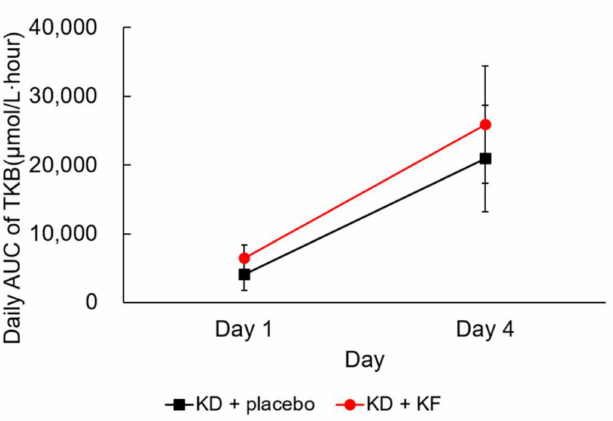
Figure 2. Flow diagram of research subjects. Abbreviations; KD, ketogenic diet; KF, ketogenic formula.